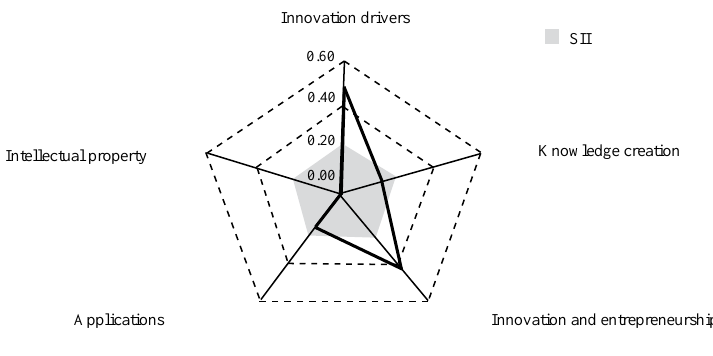
fig. 6. Performance chart by innovation dimension. Source: European Innovation Scoreboard ...